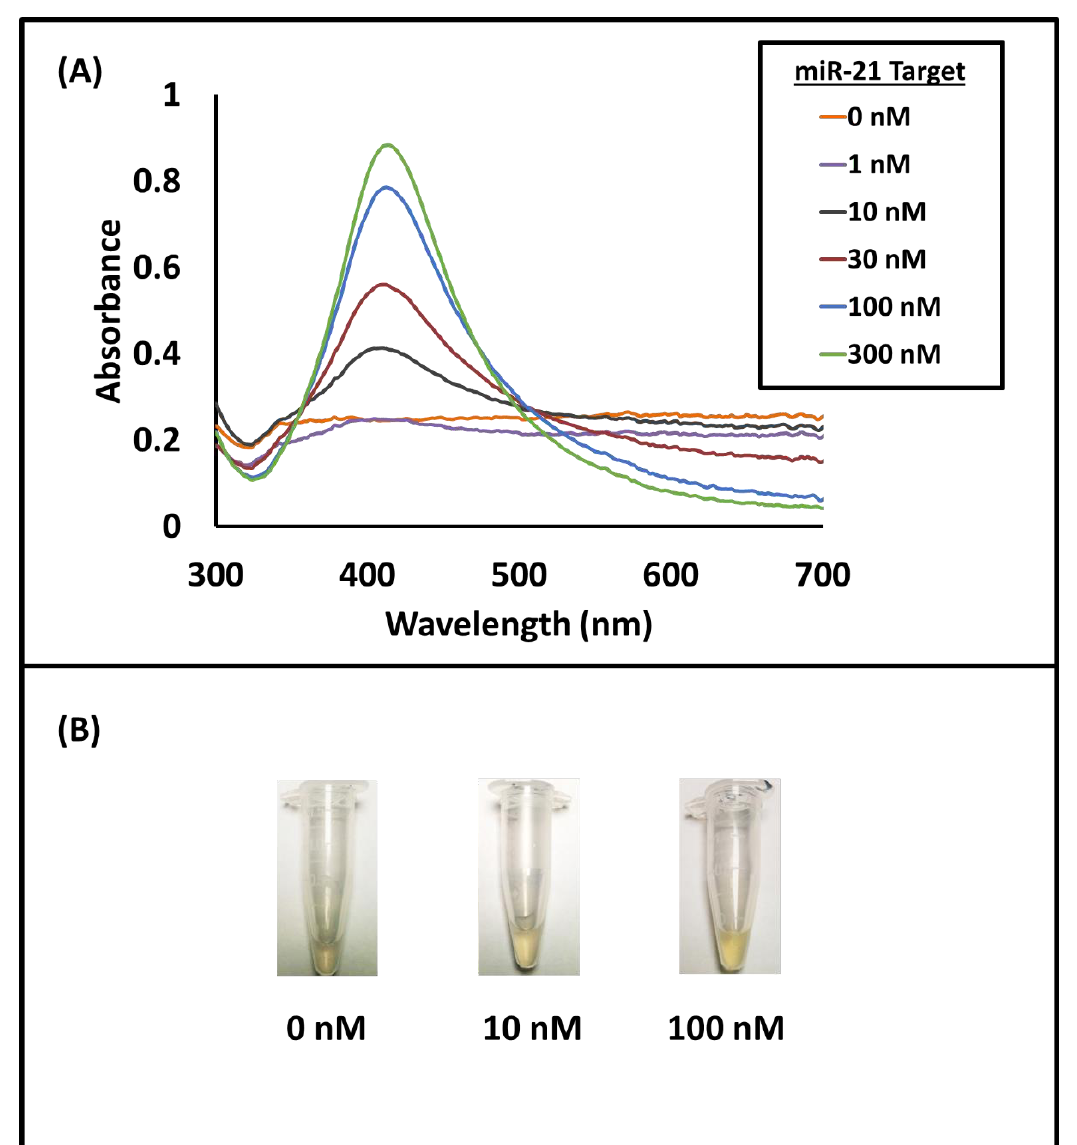
Figure 4. ( A ) Absorption spectra of samples with different miR-21 target concentrations (0 – 300 nM). An increase in target concentration results in an increase in peak intensity around 412 nm and a decrease around 650 nm. ( B ) Pictures of sample solutions with 0 nM, 10 nM, and 100 nM of miR-21 target. A larger amount of miR-21 target results in a stronger yellow color of the sample solution.